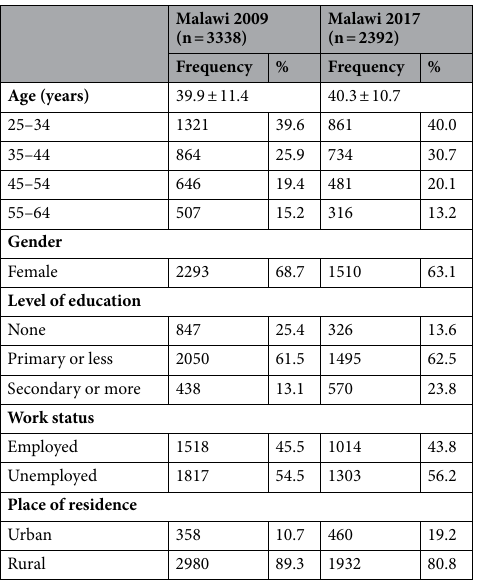
Table 2. Sociodemographic characteristics of Malawian adult participants aged 25 to 64 years in 2009 and 2017 (with sampling